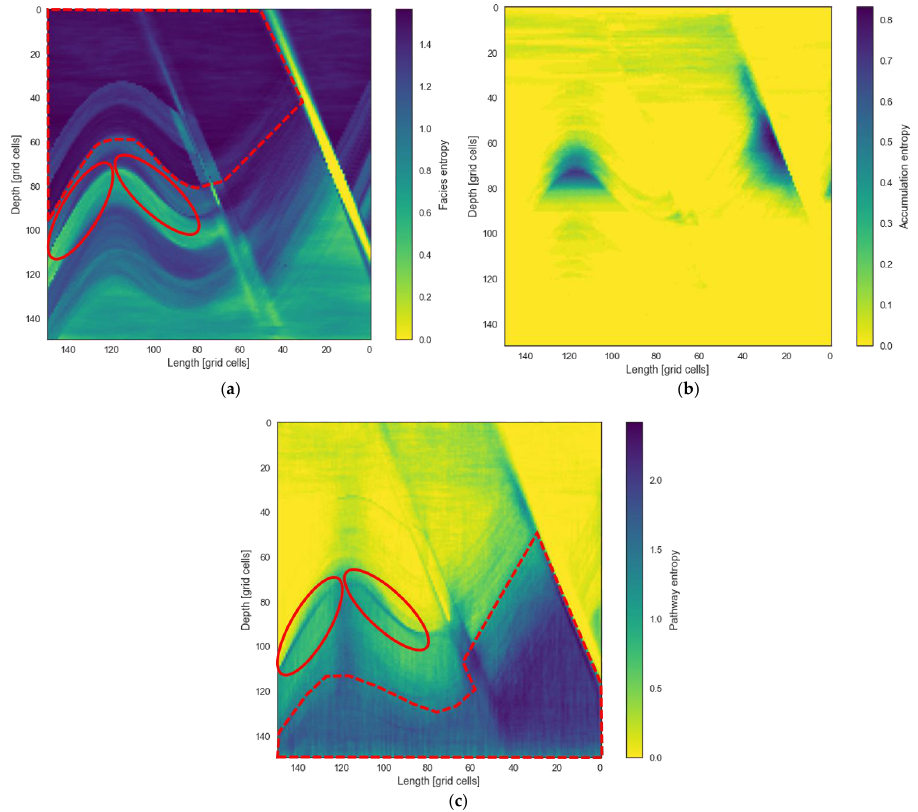
Figure 11. Two-dimensional slices through the model of the entropy distribution of all simulation runs for facies ( a ), accumulation location ( b ), and migration pathways ( c ).